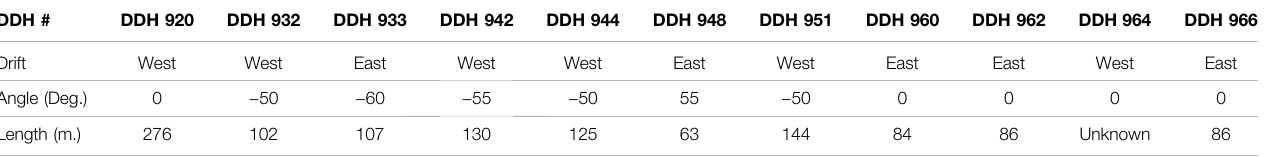
TABLE 1 | Physical characteristics of